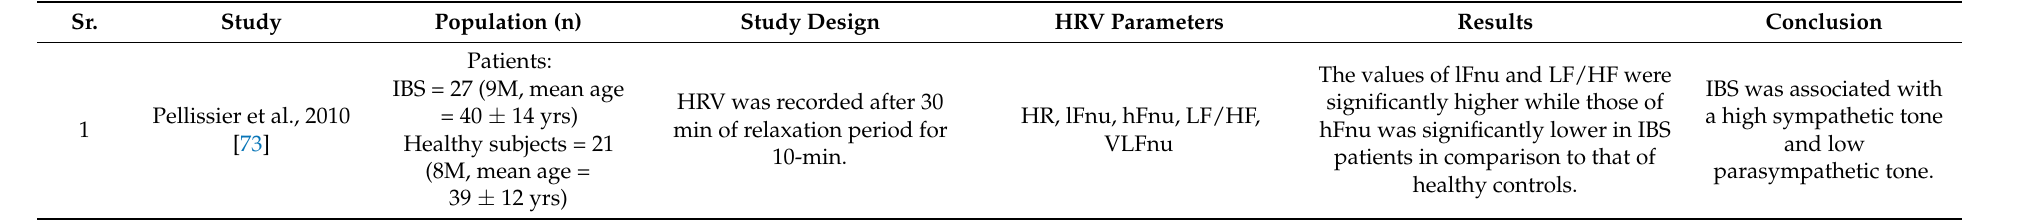
Table 4. Summary of studies: Autonomic Nervous System and Irritable Bowel Syndrome (IBS).